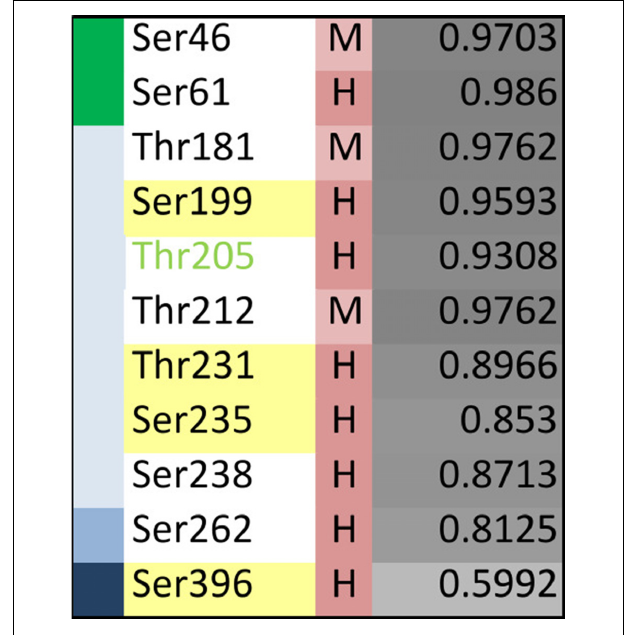
FIGURE 6 | Evolutionary changes of specific tau phosphorylation sites of pathological relevance. Summary representation showing phosphorylation sites that have been reported to be significantly enriched in cerebrospinal fluid (CSF) from AD patients compared to controls (based on Russell et al., 2017). The different tau regions are indicated in green (NTR), gray (PRR), light blue (MBR) and dark blue (CTR). The level of conservation is indicated as described in the legend of Figure 5 . The extent of disorder is color-coded from light to dark grey with darker colors showing higher disorder. Thr205 is shown in light-green as its phosphorylation has been shown to decrease A β -induced toxicity (Ittner et al.,